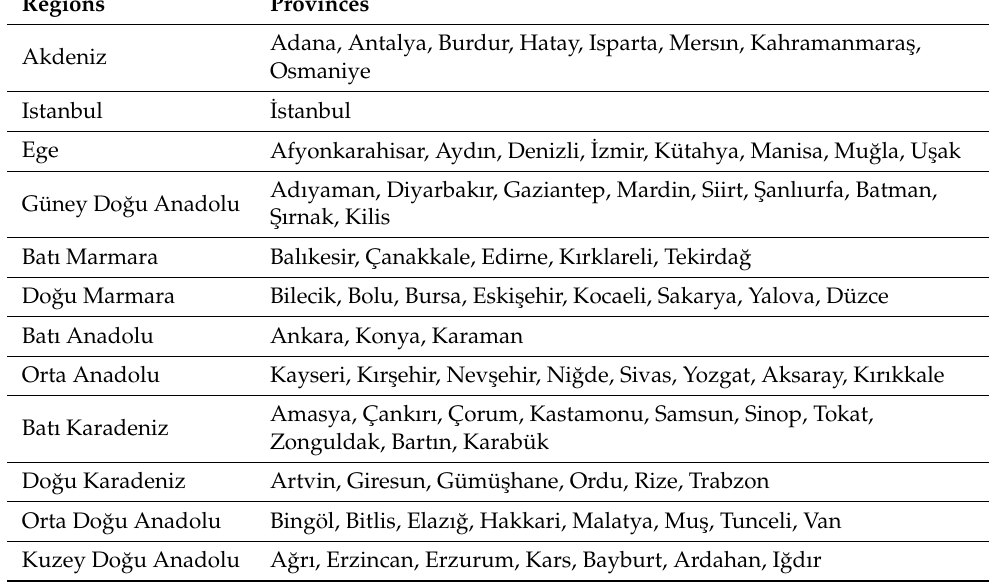
Table 1. Regions and Provinces of Turkey. Regions